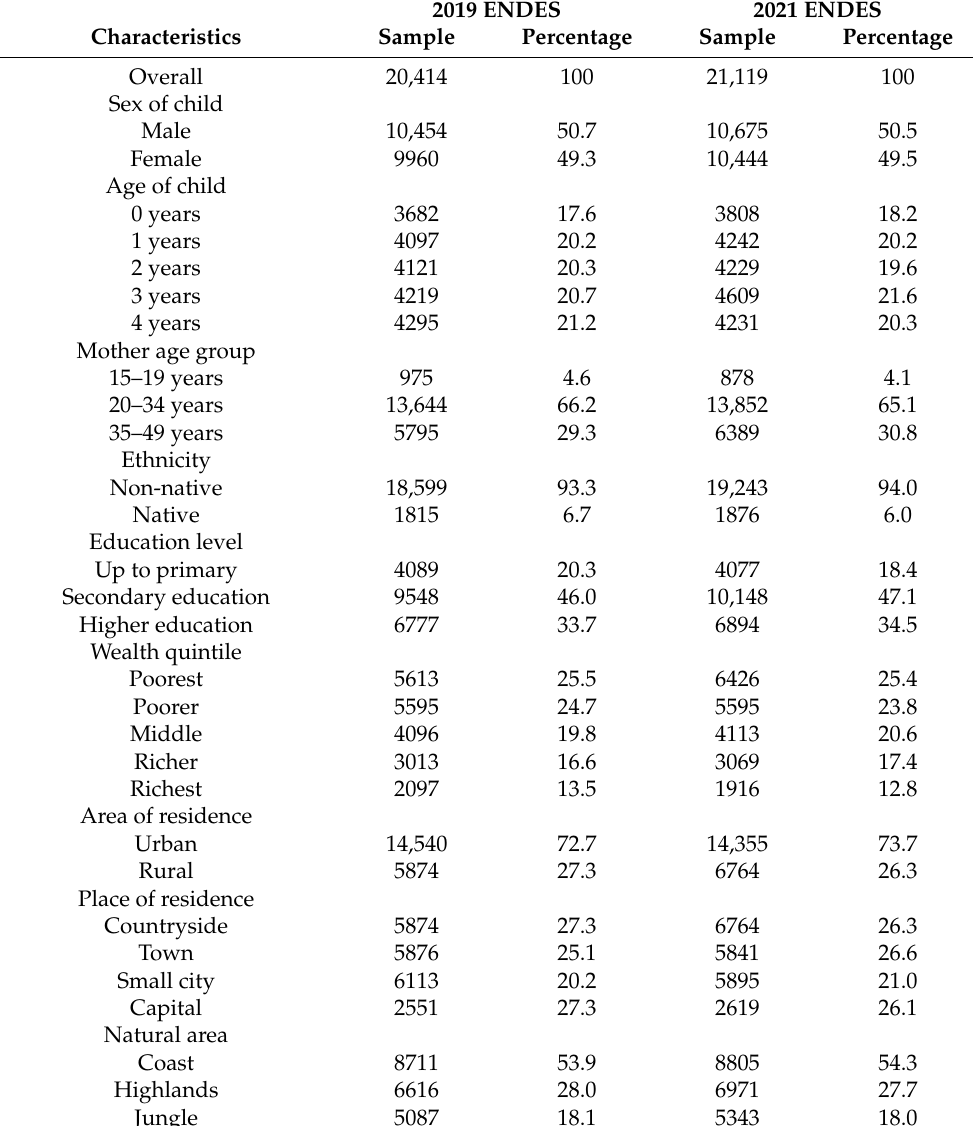
Table 1. Summary statistics of children under 5 years of age and their mothers included in the